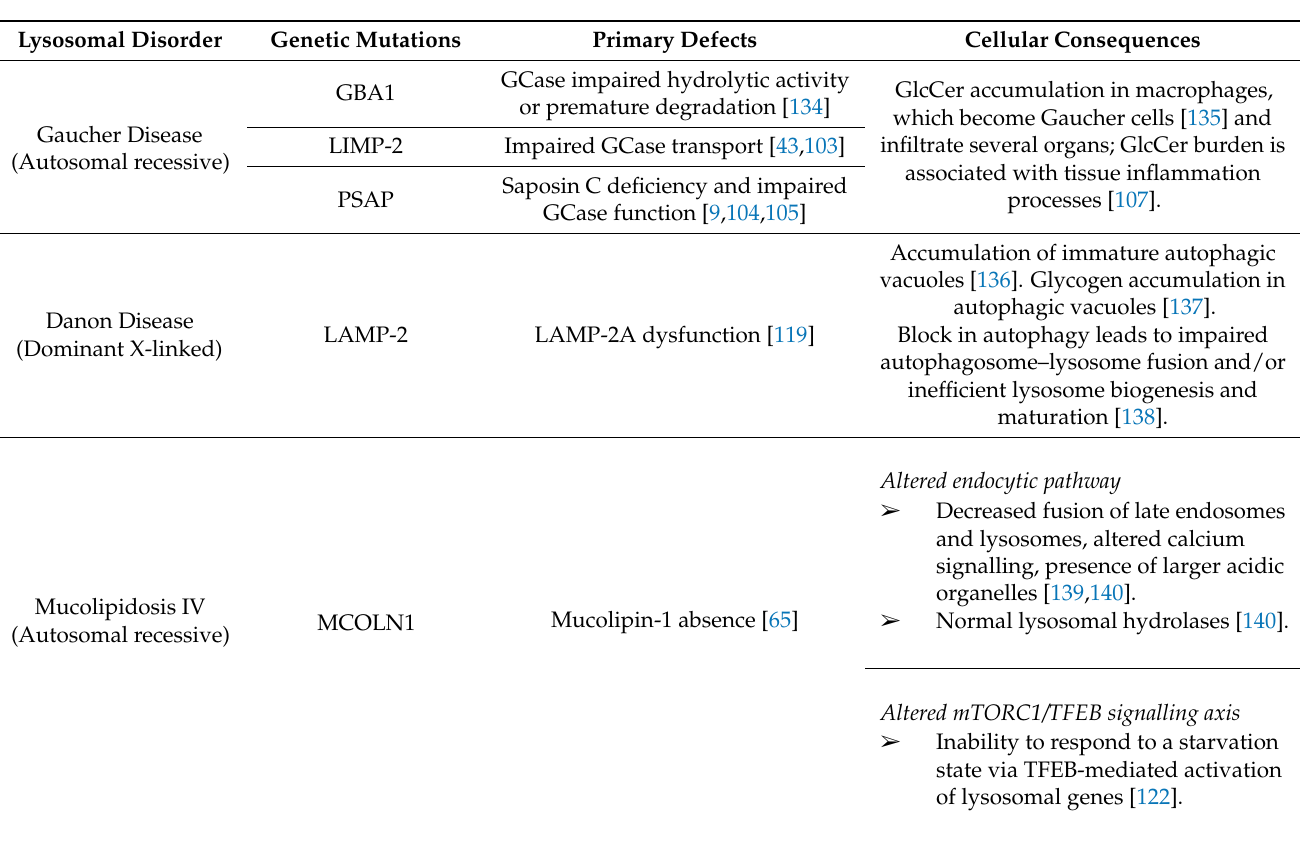
Table 1. Examples of Lysosomal Storage Diseases with different primary defect